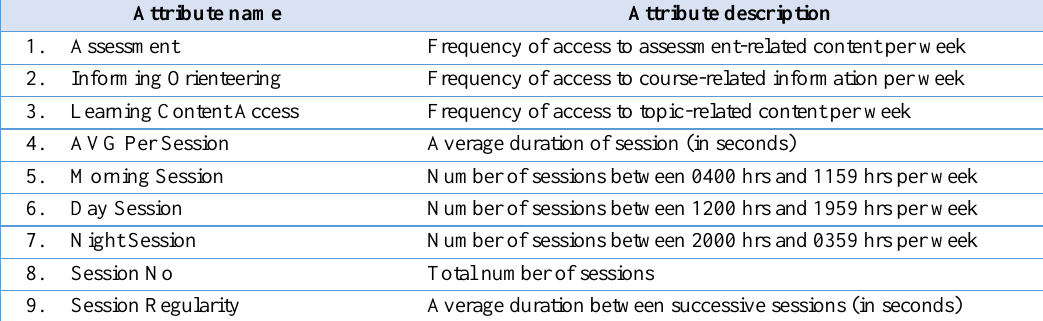
Engagement Measures Generated from LMS Activity